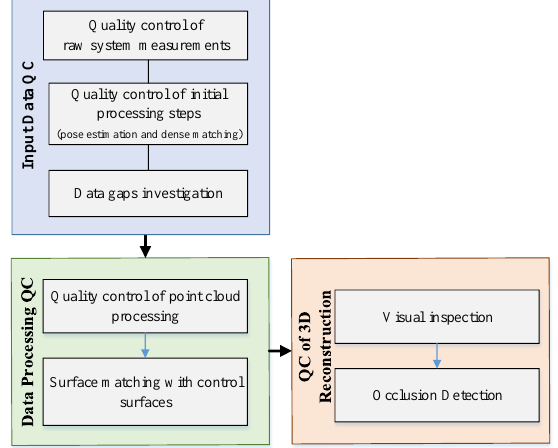
Figure 1. The outline of the proposed procedure for quality analysis of 3D reconstruction using photogrammetric data